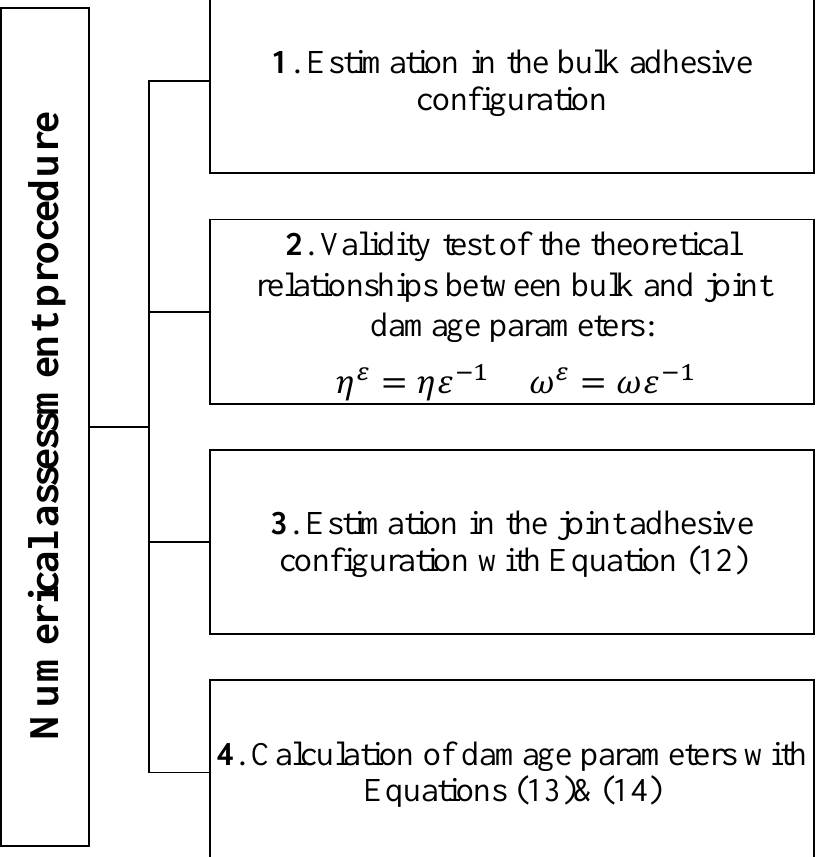
Figure 1. Flow chart detailing the numerical assessment procedure.